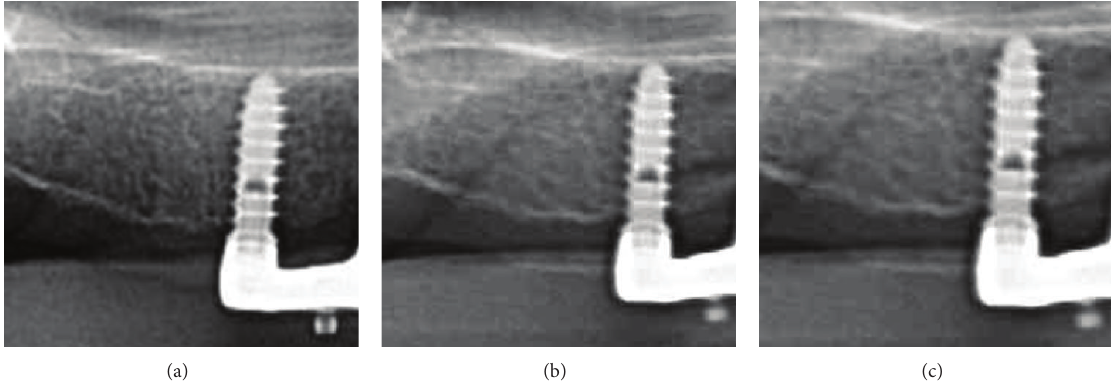
Figure 6: Periapical radiographs of an implant at the 1-year (a), 2-year (b), and 3-year (c) follow-up examination,